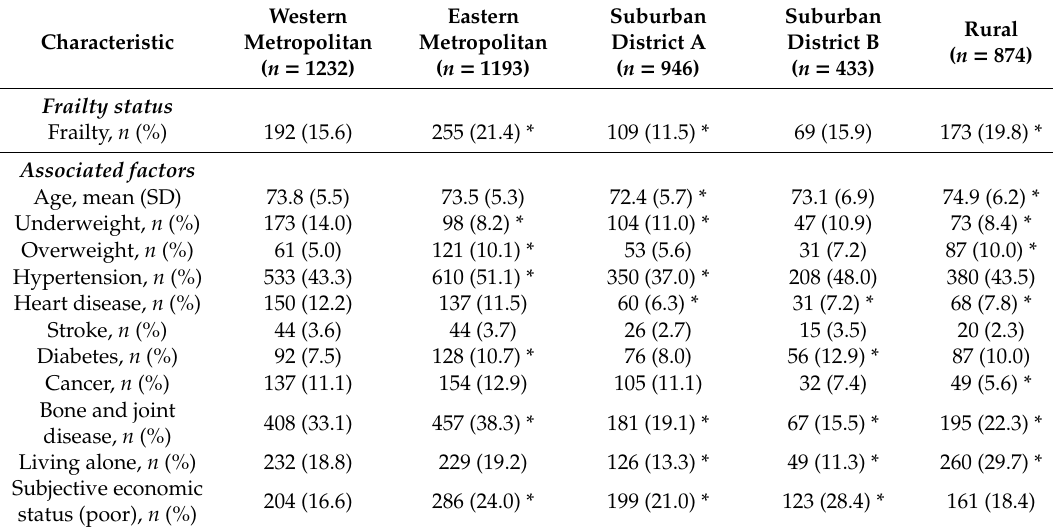
Table 2. Characteristics of women in each